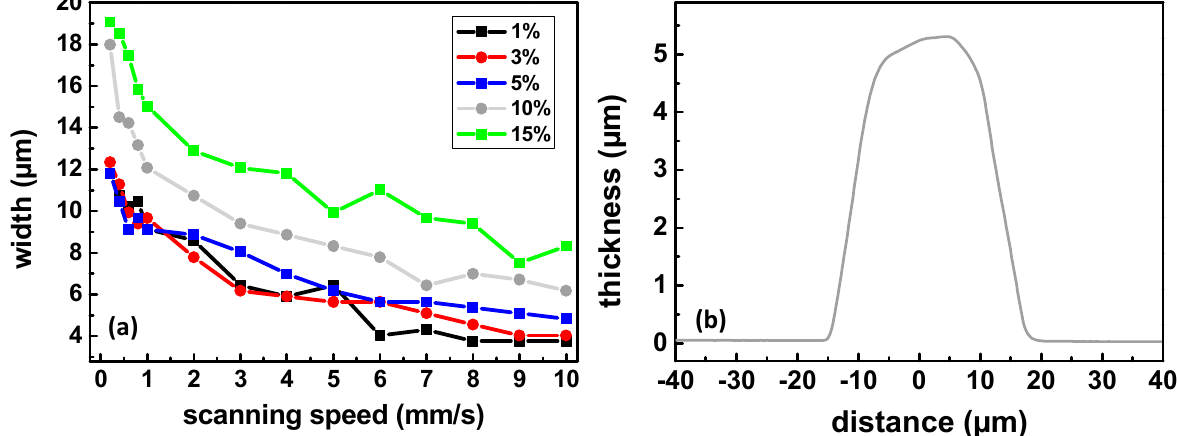
Figure 8. Characterization of the photo-induced patterns using the Dilase 750 facility. ( a ) Width of the structures as a function of the scanning speed for powers ranging from 1% and 15% and ( b ) profile obtained for a line written at 10% and 200 µm/s.